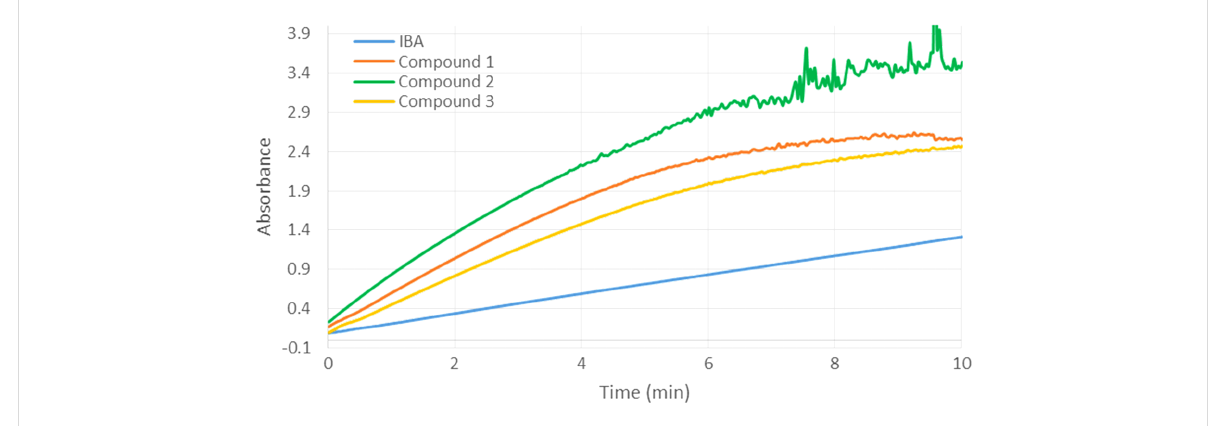
Figure 6: Hydrolysis of methyl paraoxon (0.5 mM) in the presence of compounds 1 , 2 , 3 or 2-iodosobenzoic acid (IBA) at 0.5 mM concentration.